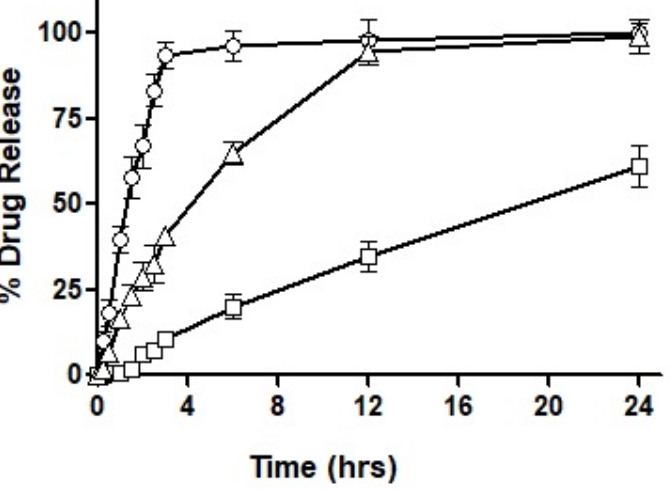
Figure 7. Percentage of ACV release from the nanoemulsions prepared from F3 ( ◯ ), F4 ( □ ) and F7 ( △ ) separately in 0.1 M phosphate buffer pH 6.8 for 24 h using the dialysis tube method.